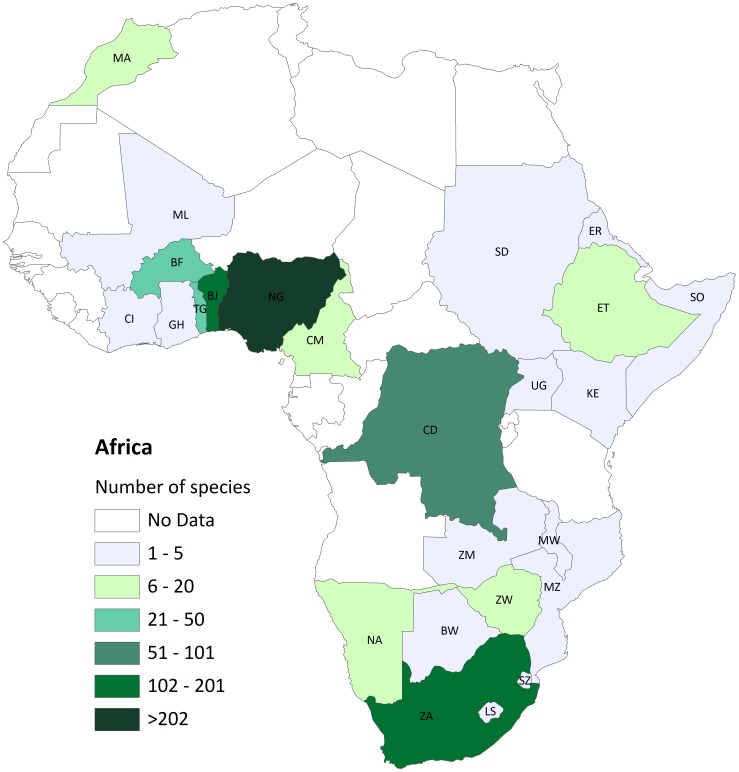
Bird species traded for traditional medicine.number of species across 25 African countries.